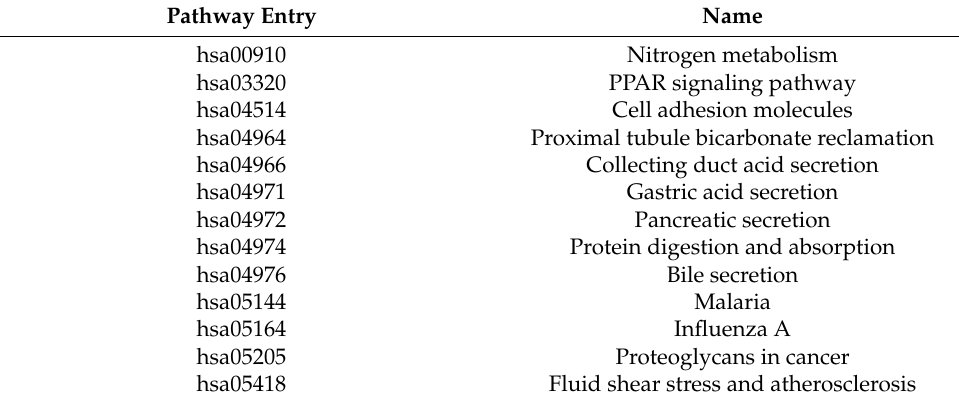
Table 6. List of KEGG pathway entries and